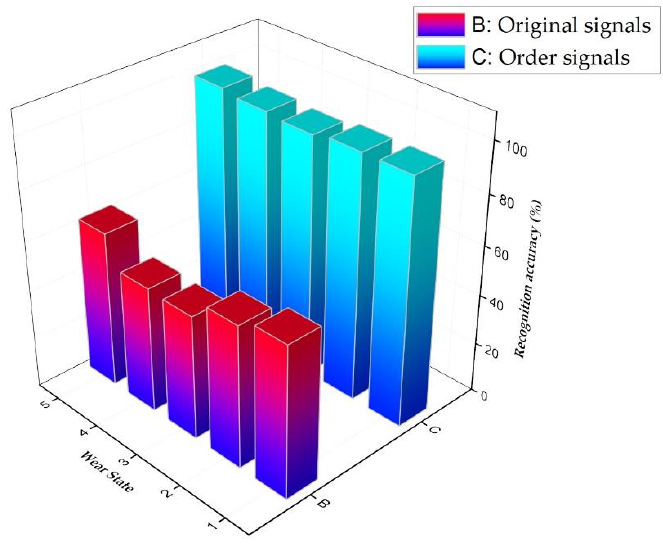
Figure 8. The results of the comparison of the two methods.